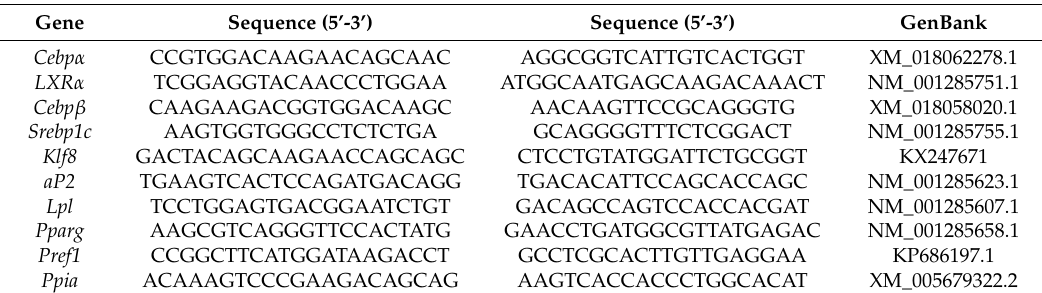
Table 1. Primers for quantitative real-time PCR